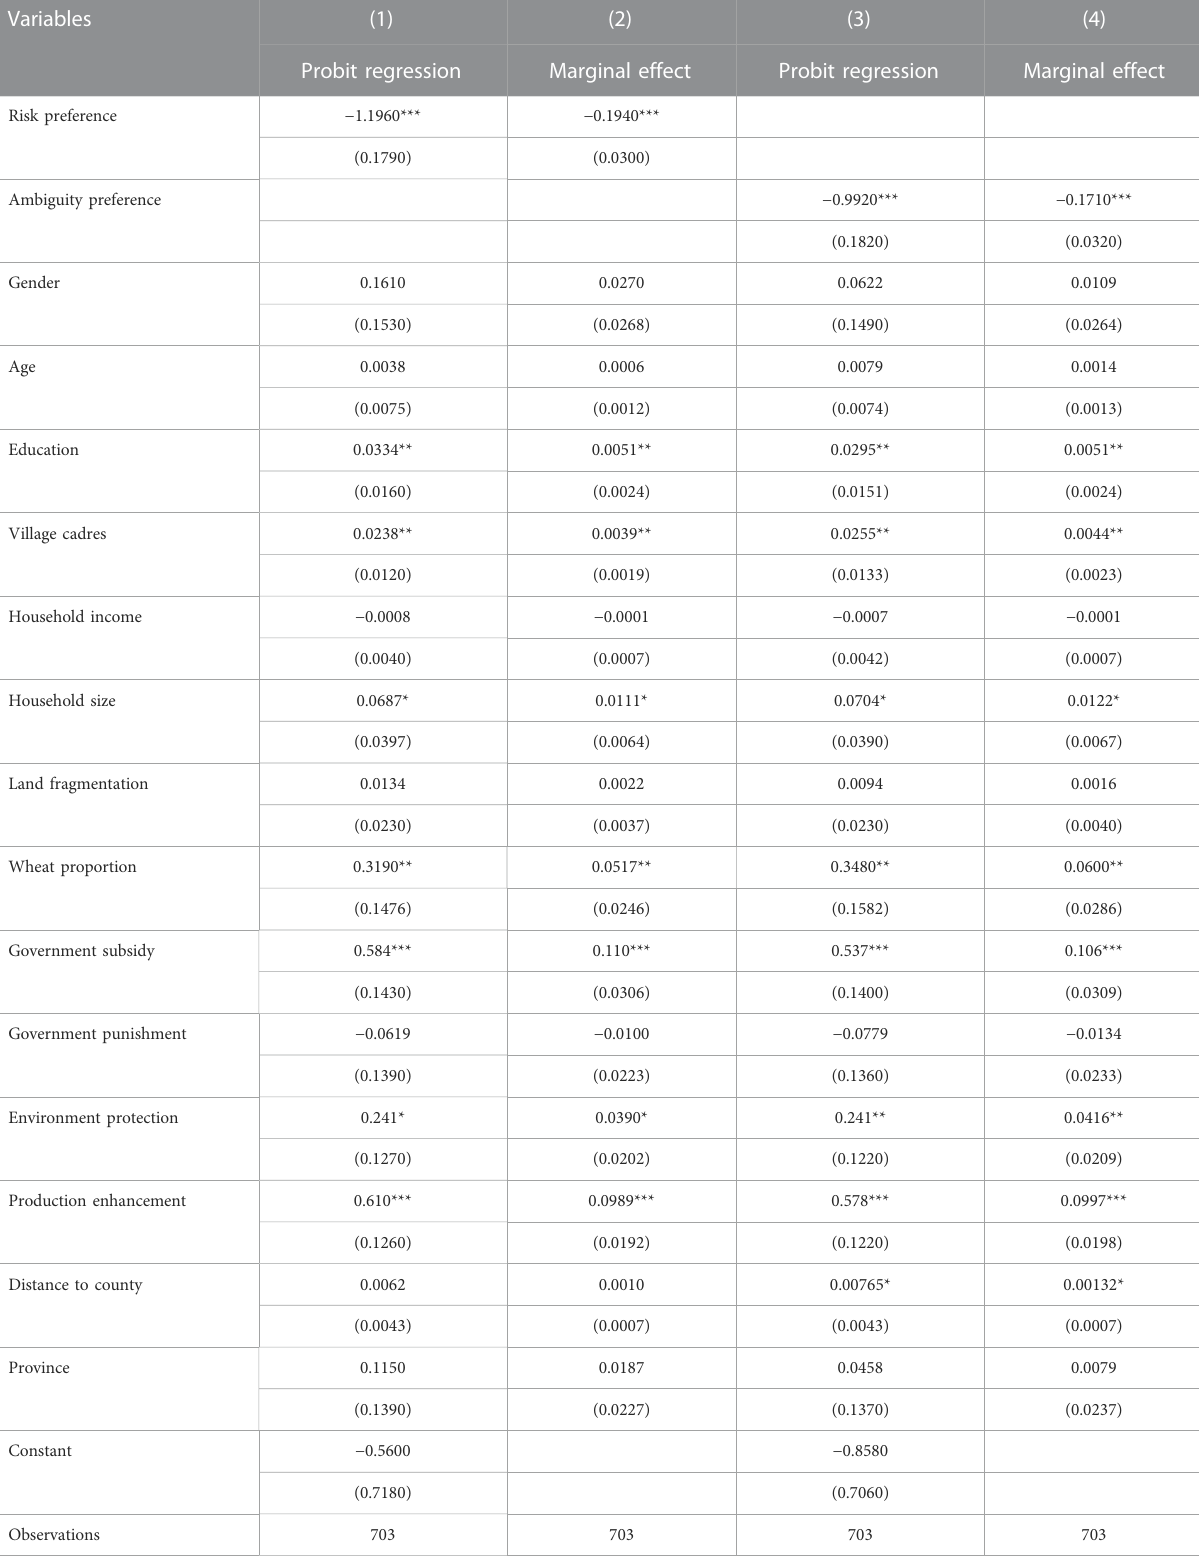
TABLE 6 Regression of the impact of uncertainty on straw returning technology